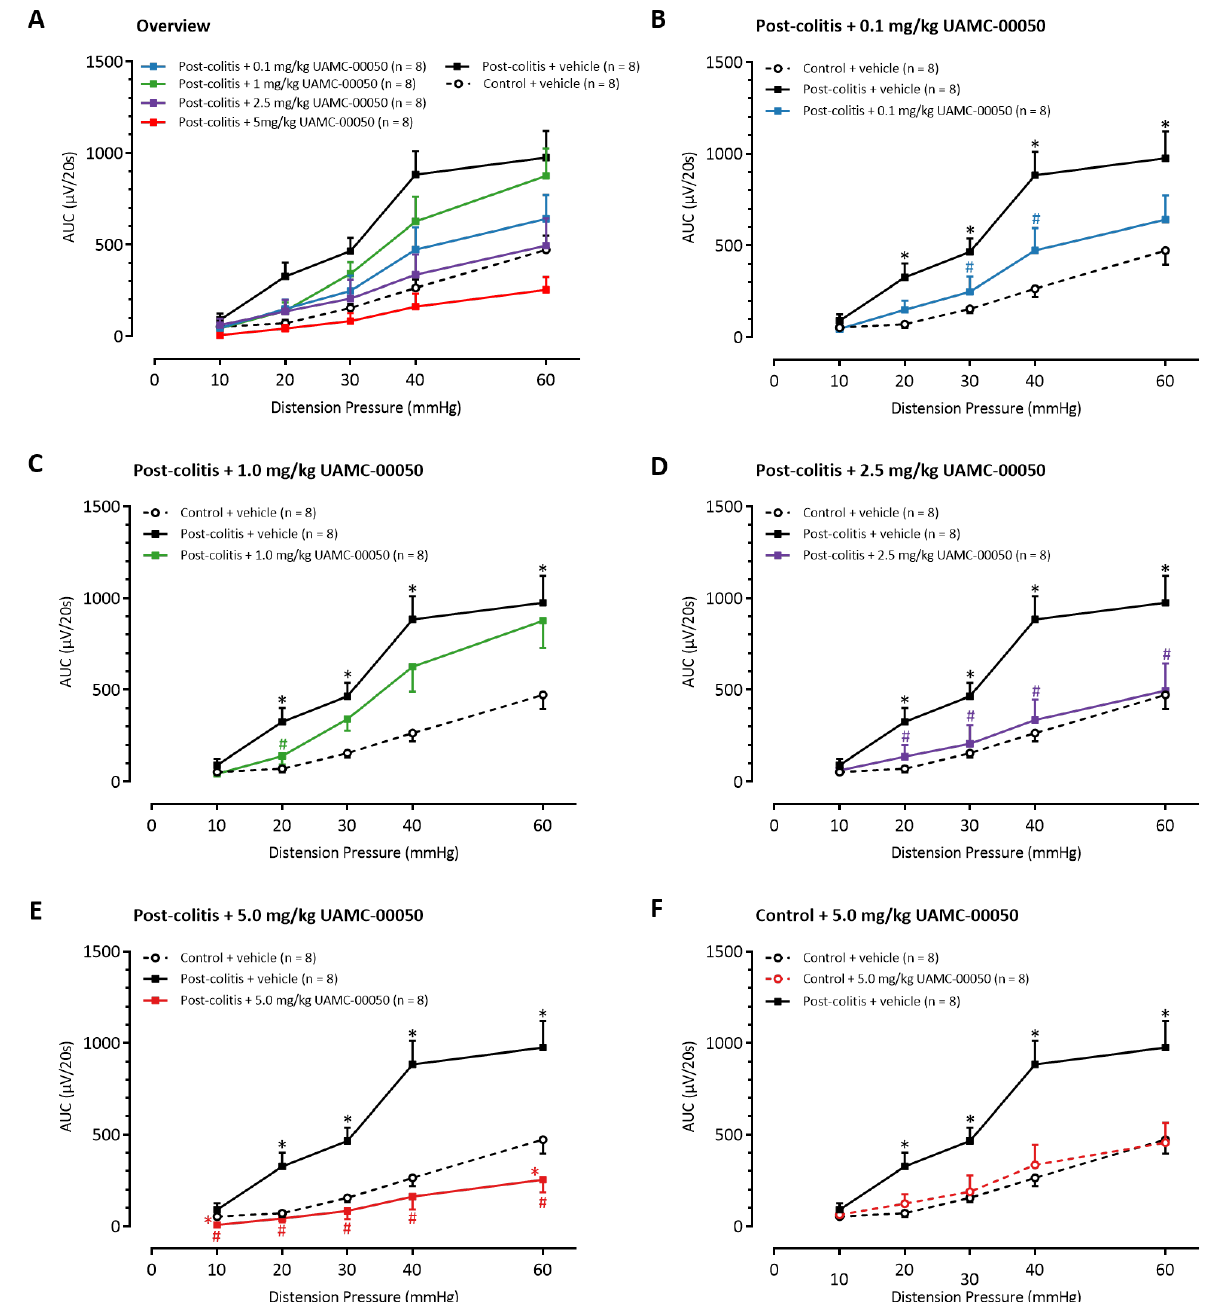
Figure 7. The effects of intracolonic administration of UAMC-00050 (0.1–1.0–2.5–5.0 mg/kg) and its vehicle (5% DMSO in H 2 O) on visceral sensitivity in post-colitis (filled squares) and control (open circles) rats. Statistical analysis was performed on the complete dataset ( A ), however separate graphs ( B – F ) were generated for each dose for the purpose of clarification. Data are presented as means ± SEM. Generalized estimating equations using an unstructured working correlation matrix, followed by a least significant difference (LSD) post hoc test; n = 8 per group. Note: * p < 0.05; significantly different from control + vehicle. Note: # p < 0.05; significantly different from post-colitis + vehicle.